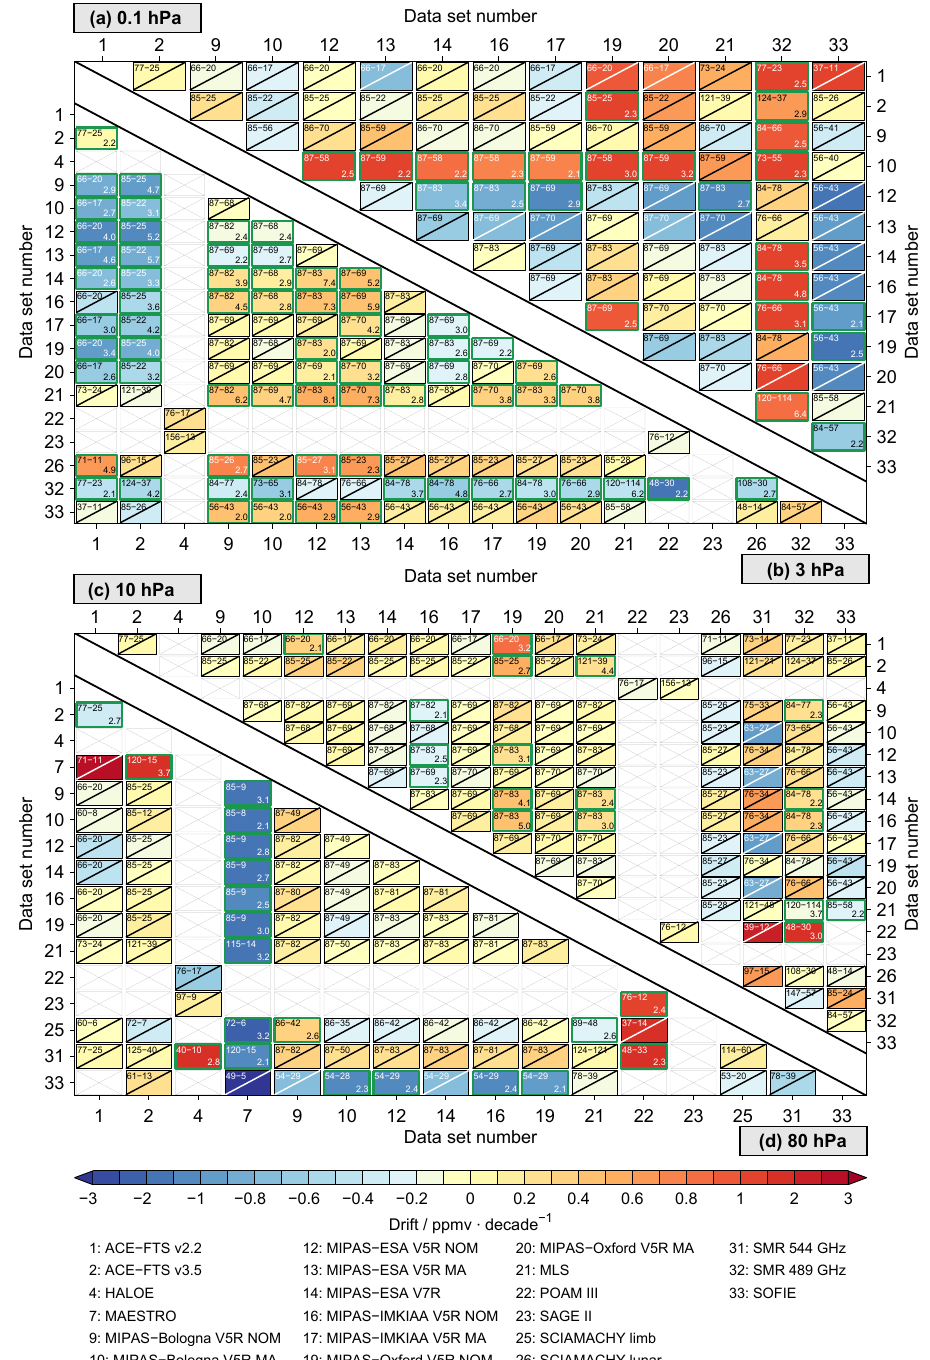
Figure 11. Drifts between the different data sets in the latitude band between 80 ◦ and 70 ◦ S at four specific altitudes. The drift estimates are based on the difference time series between the data sets given on the x axis and the data sets given on the y axis. Additional information is given in the result boxes: the overall time period the two data sets overlap, how many months the data sets actually overlap (upper left corner) and if the drifts are significant (green frame) or not significant (slant) at the 2 σ uncertainty level. The significance level is given in the lower right corner in cases where the drift is